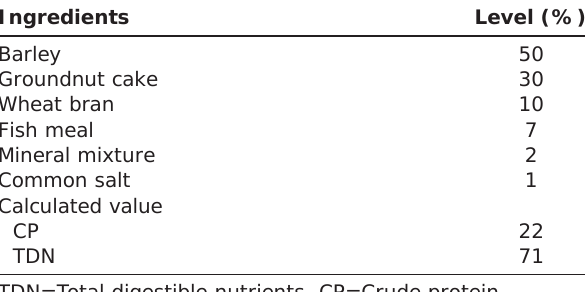
Table-1b: Composition of calf starter.